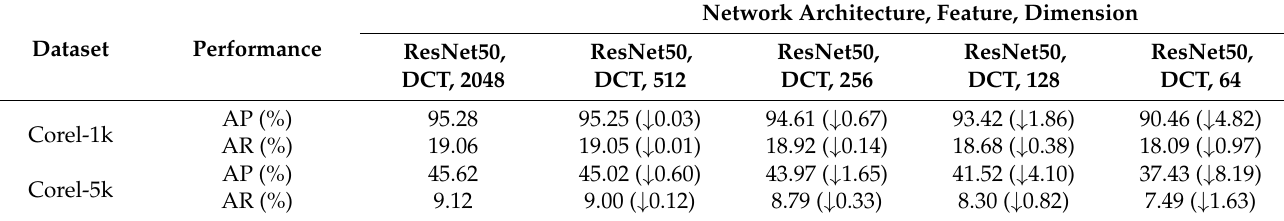
Table 7. APs and ARs results by applying DCT to deep features, Top NR = 20.